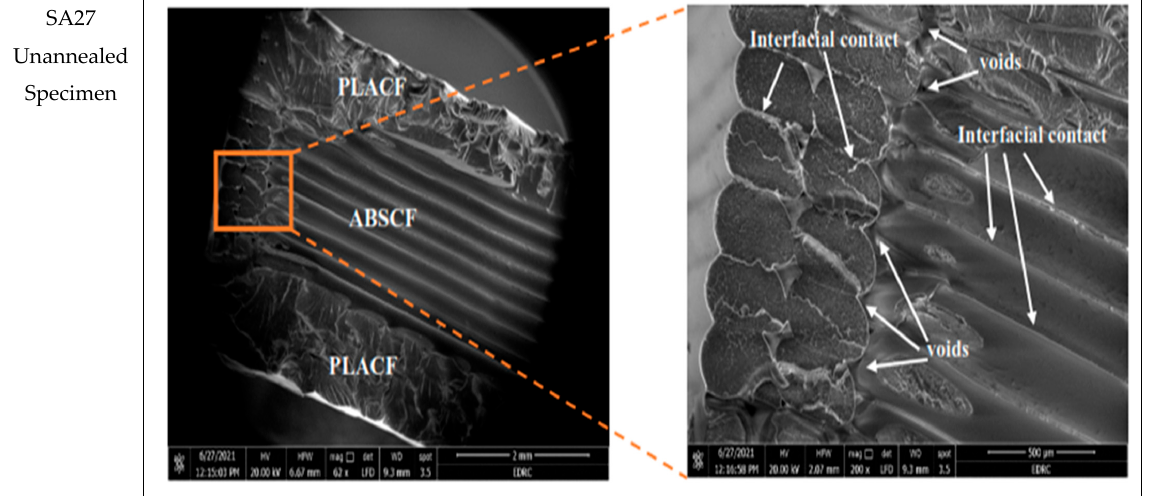
Figure 10. SEM photos of unannealed SA27specimen.